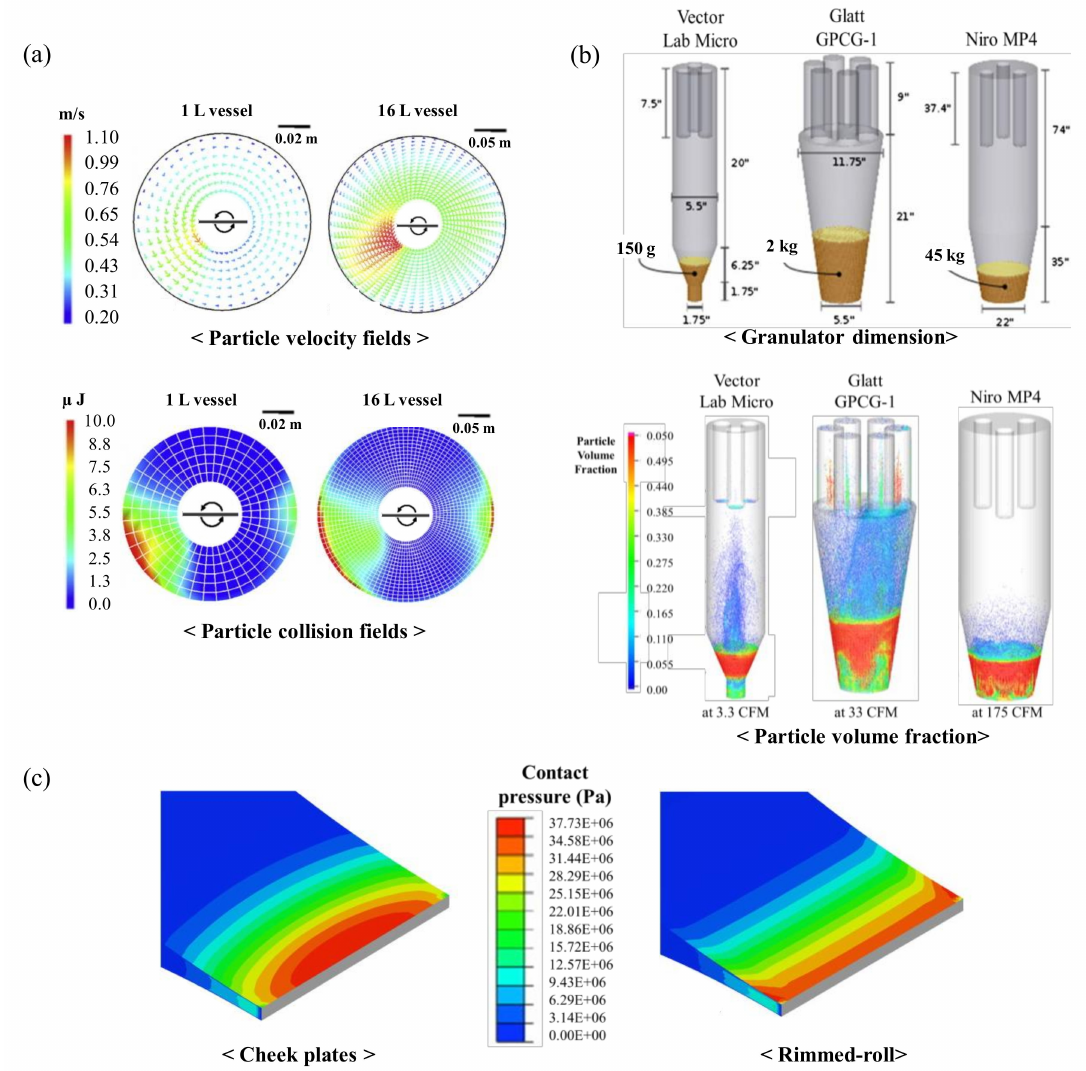
Figure 3. Application of physics-based modeling method for pharmaceutical scale-up process: ( a ) Discrete element method (DEM) predictions (particle velocity and collision fields) in a high-shear granulator (1 L and 16 L) [64]; ( b ) Computational fluid dynamics (CFD) simulation in three scale of fluidized bed granulator [78]; ( c ) FEM simulation for compared contact pressure with cheek plates and rimmed-roll [79]. The figures were slightly modified, with permission from